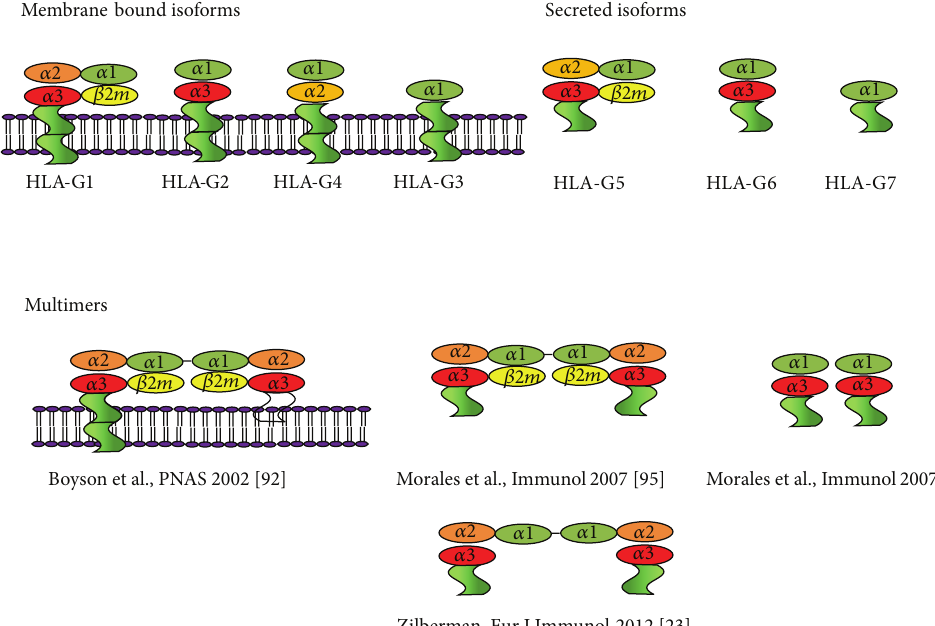
Figure 2: HLA-G isoforms and conformations. Membrane and soluble HLA-G isoforms are reported as monomeric and dimeric conformation Zilberman, Eur J Immunol 2012